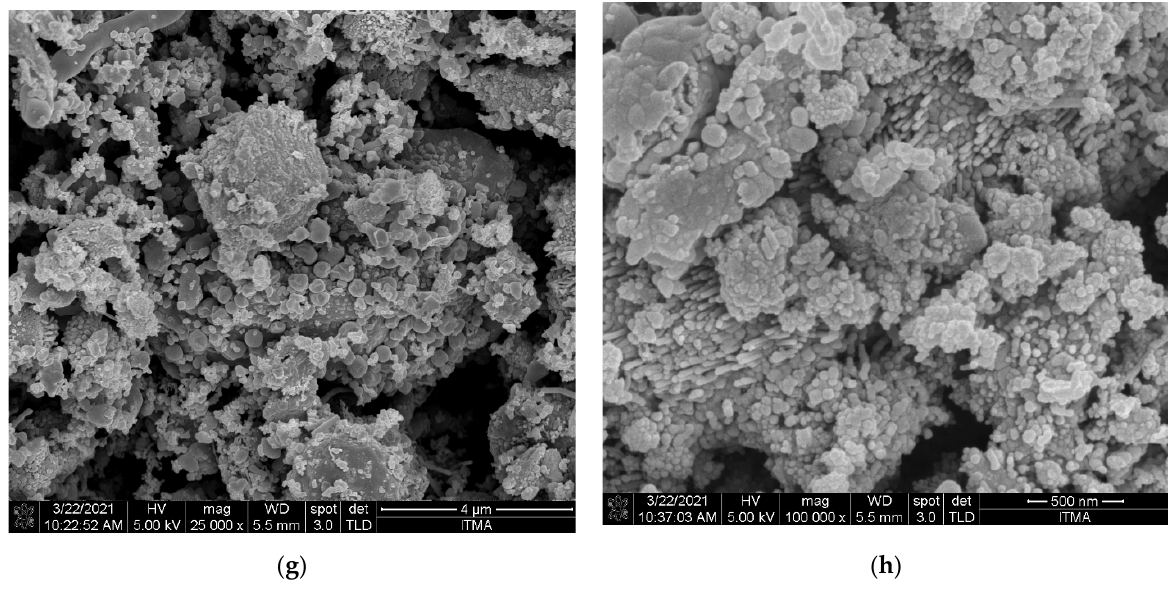
Figure 4. FESEM images of C-450 at magnifications of ( a ) 25 kx and ( b ) 100 kx; C-500 at magnifications of ( c ) 25 kx and ( d ) 100 kx; C-550 at magnifications of ( e ) 25 kx and ( f ) 100 kx; C-600 at magnifications of ( g ) 25 kx and ( h ) 100 kx.